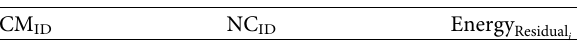
Figure 13: Routing Architecture envisioned in the current work. Table 3: Message packet from